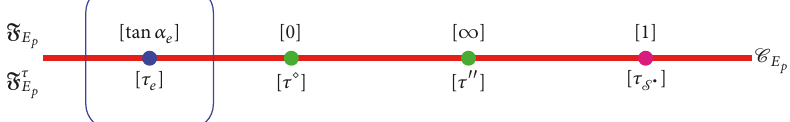
Figure 9: The projective line associated with the celestial circle C 퐸